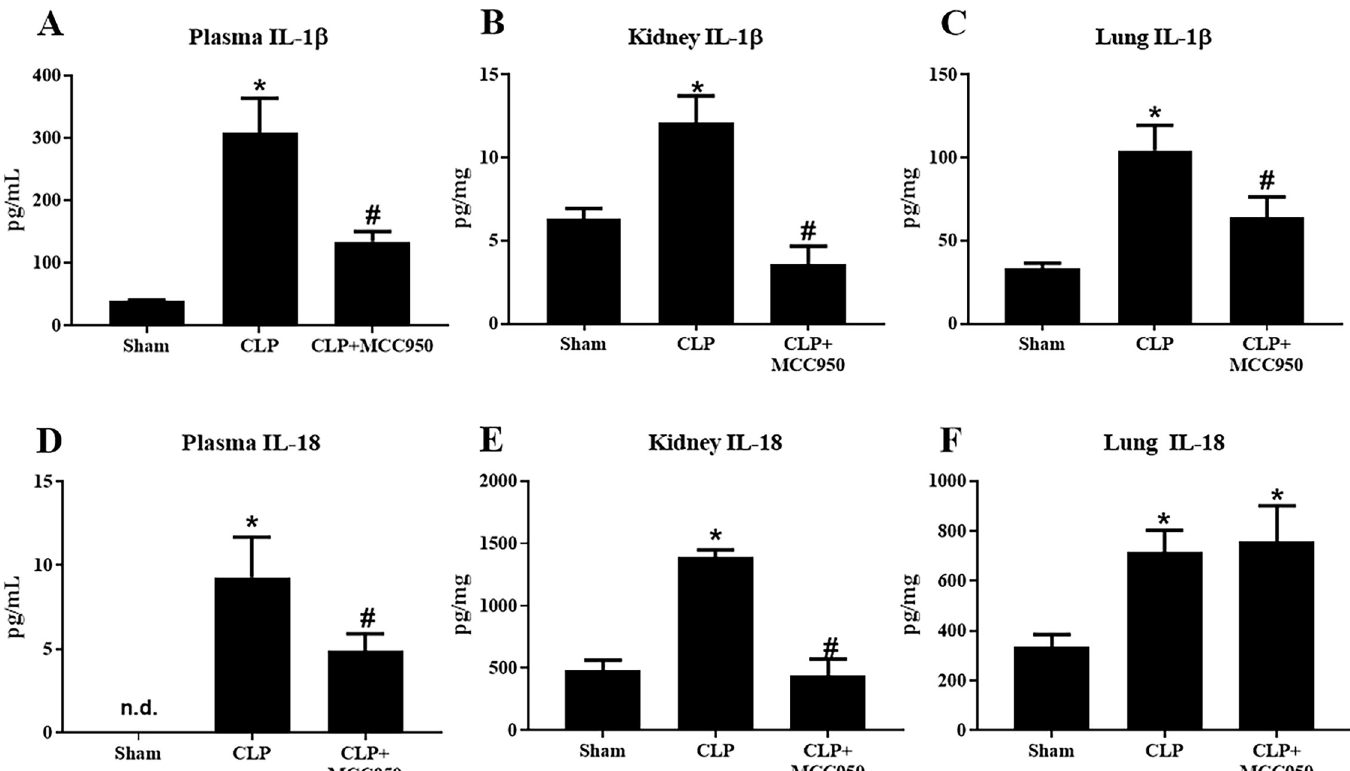
Fig 4. Inflammasome-associated cytokines. IL-1 β and IL-18 protein levels in response to CLP. Plasma (A and D), kidney (B and E), and lung (C and F) IL-1 β and IL-18 were measured via ELISA in Sham, CLP, and CLP rats treated with MCC950 ( n = 12/group). � P < 0.05 versus Sham � p < 0.05 vs Sham, #p < 0.05 vs CLP.